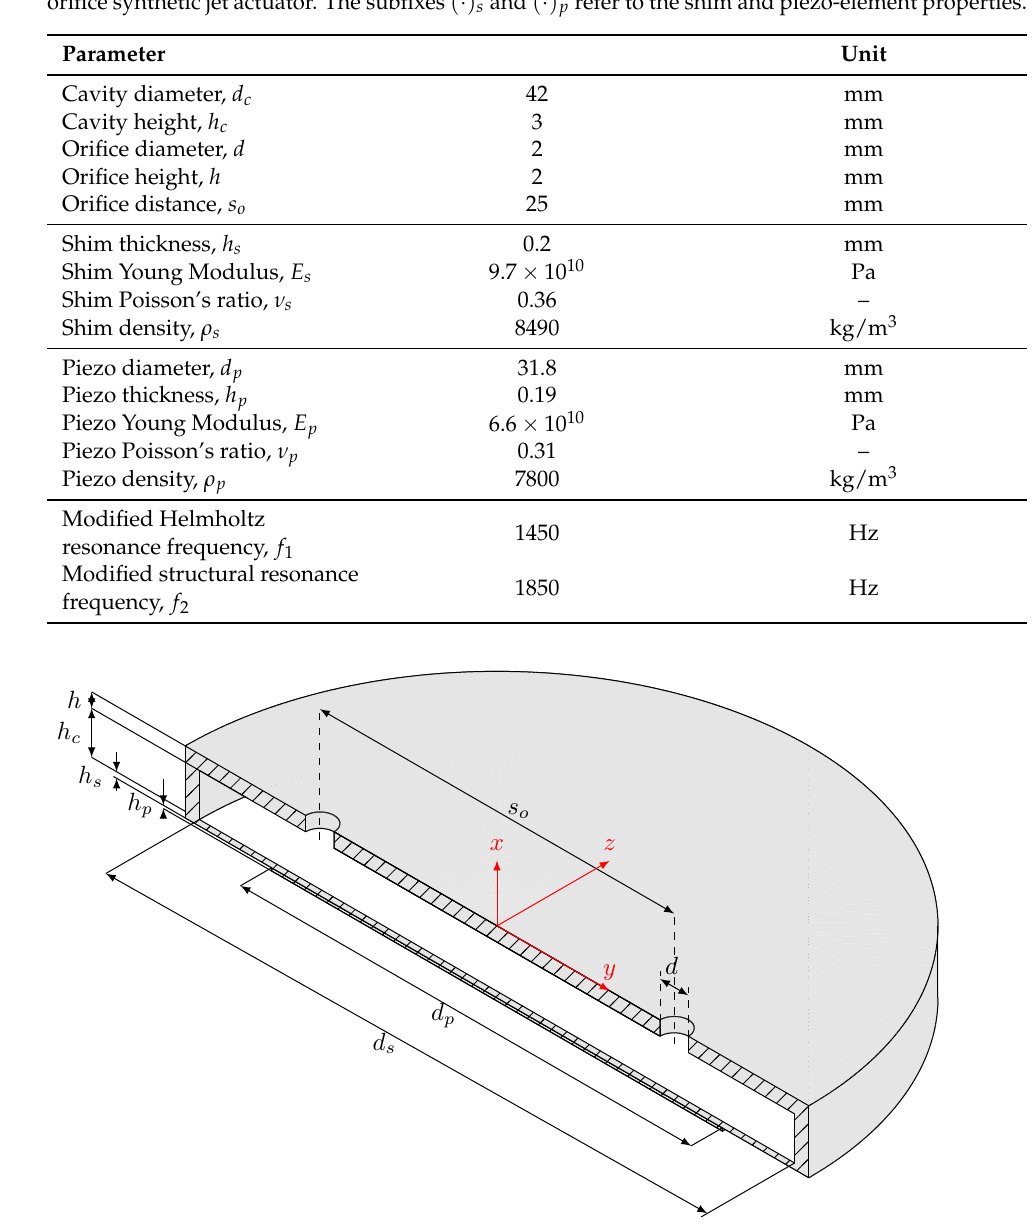
Table 1. Geometrical characteristics, mechanical properties and resonance frequencies of the double- orifice synthetic jet actuator. The subfixes (